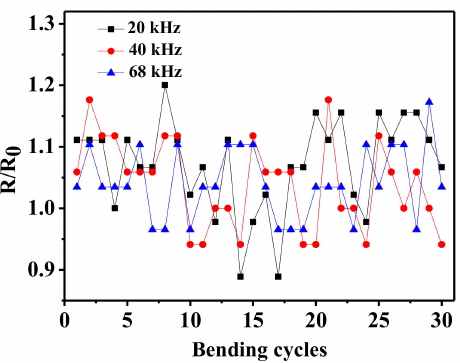
Figure 11. Normalized sheet resistance of the SVPT PEDOT:PSS films deposited on flexible PET/ITO